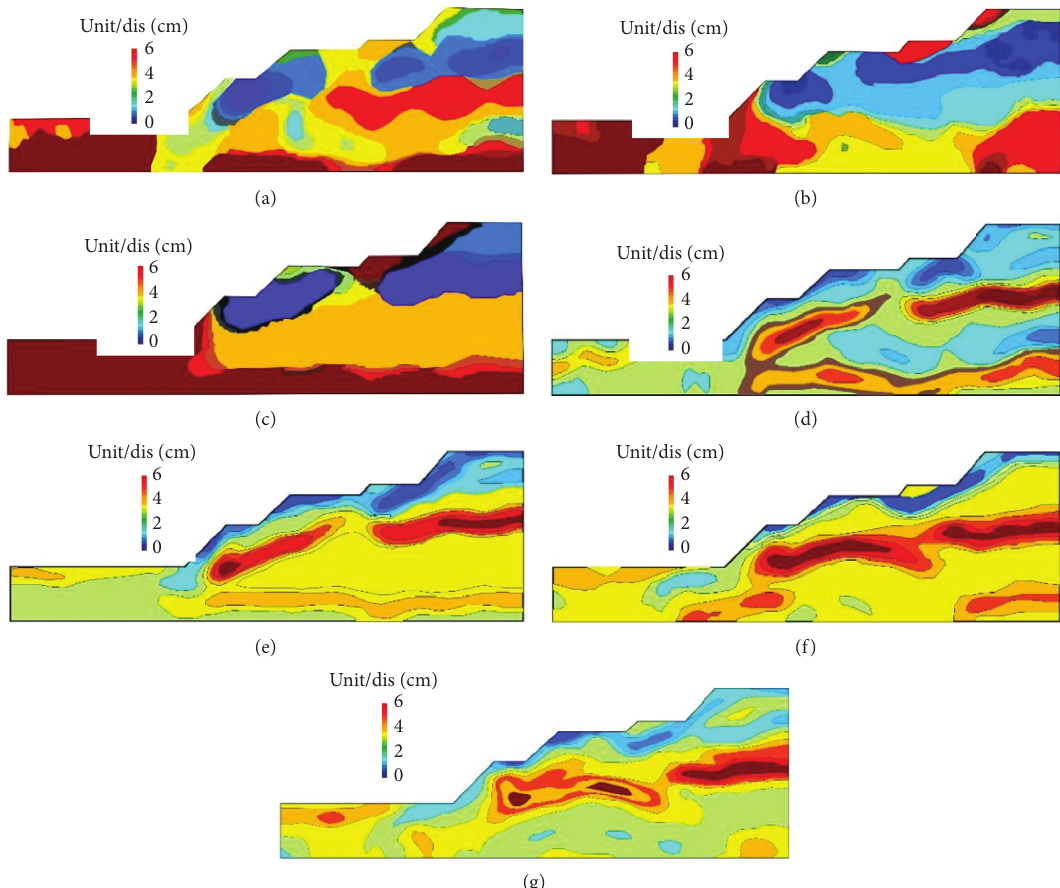
Figure 5: Evolution process of the slope under the input dynamic load with a frequency of 35 Hz during the whole failure process. (a–c) Displacement evolution. (d–g) Shear strain evolution.